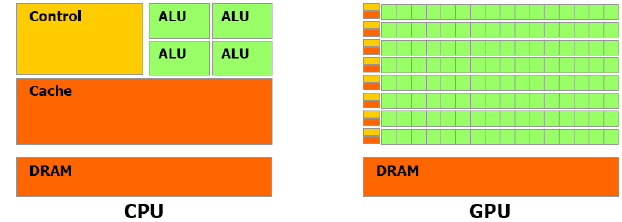
Figure 2. Schematic chip representation for both the central pro- cessing unit (CPU) and the graphical processing unit (GPU) archi- tecture (Nvidia, 2007). The latter is made of thousands of arithmetic logical units (ALUs). The CPU architecture is primarily dedicated to controlling units and cache memory, and the physical space al- lowed for ALUs is considerably reduced compared to a GPU archi- tecture.